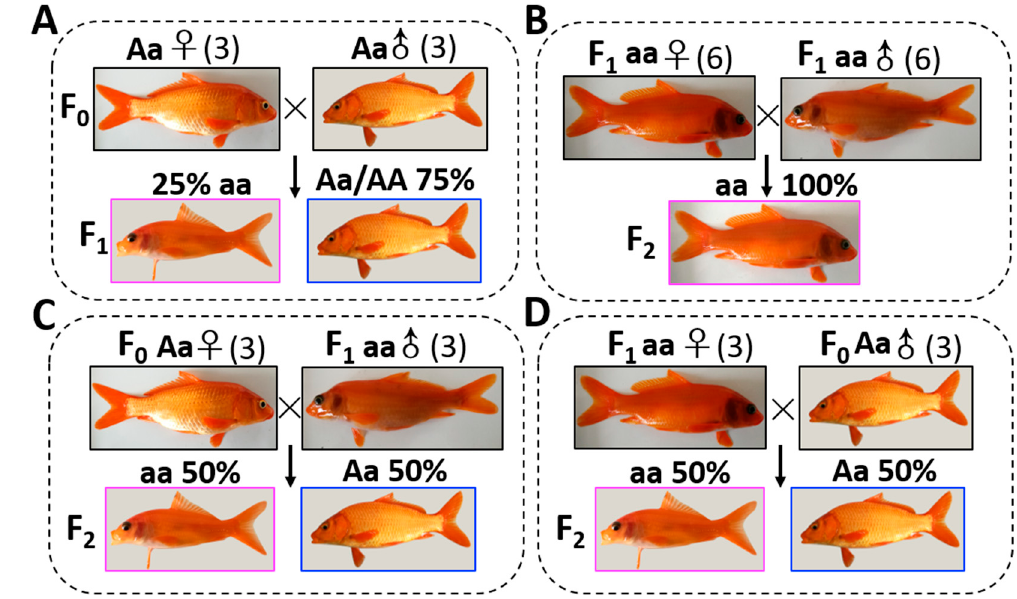
Figure 1. Genetic analysis of transparent trait. ( A ) The wild types (WTs) in the carp–goldfish nucleocytoplasmic hybrids (CyCa hybrids) were used as broodstocks for crossing to produce F1 generation. ( B ) After the F1 generation matured, the transparent mutants (TMs) in the F1 generation were used as parents for self-crossing to produce the F2 generation. ( C ) TMs in the F1 generation and WTs in the F0 generation were used as the male parent and female parent for back-crossing to produce the F2 generation, respectively. ( D ) TMs in the F1 generation and WTs in the F0 generation were used as the female parent and male parent for back-crossing to produce the F2 generation, respectively. When the phenotypes were easily distinguished, the number of WTs and TMs in the F1 and F2 generation were counted, respectively.